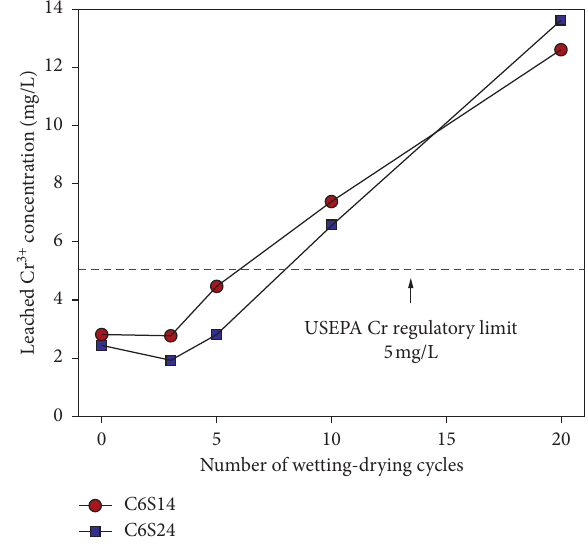
Figure 10: Evolutions of the leached Cr 3+ concentration with wetting-drying cycles of stabilized Cr-contaminated